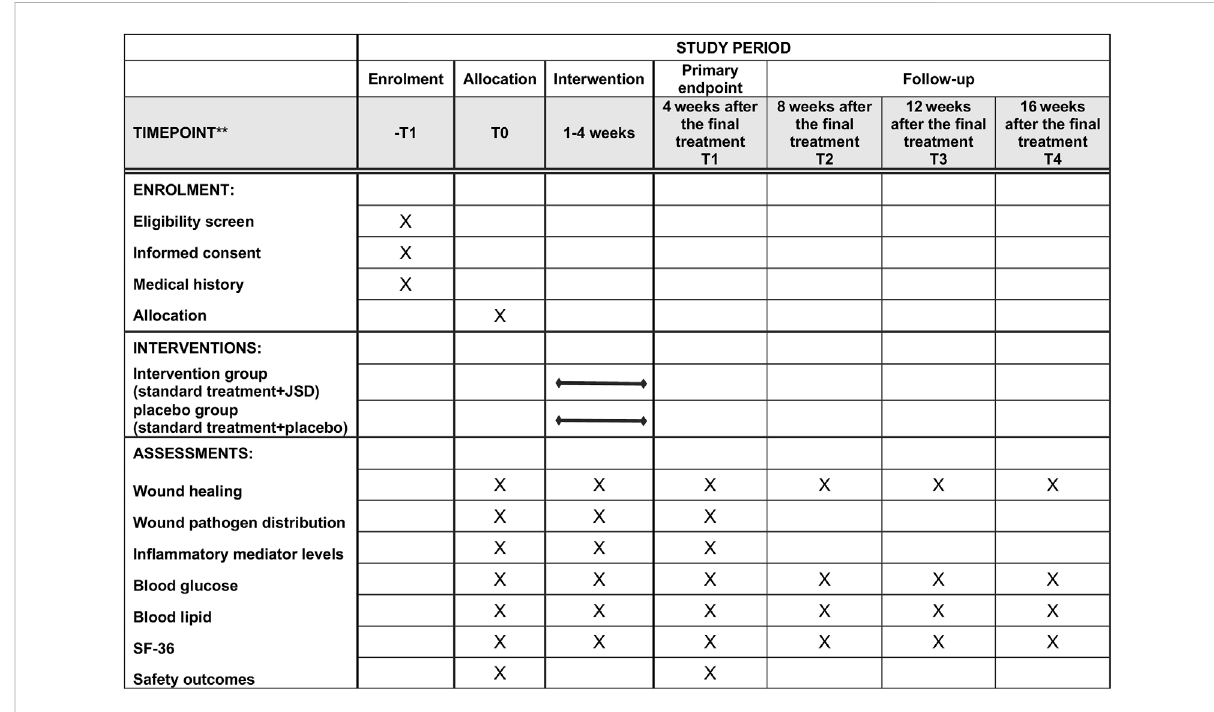
FIGURE 3 SPIRIT fi gure showing the time points for enrollment, interventions, and assessment.